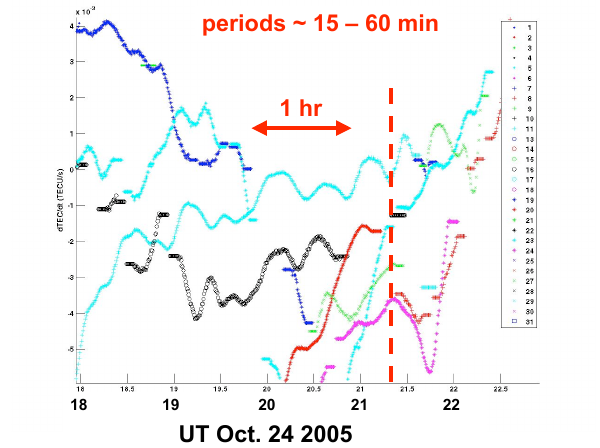
Fig. 7. Time series of d(TEC)/dt for eight GPS satellite traverses observed from Fortaleza during the evening of 24 October 2005. Note that most oscillations have apparent periods of ∼ 20min to 1h and that oscillations are apparent well before spread F and plasma bubble onset, shown approximately by the dashed red